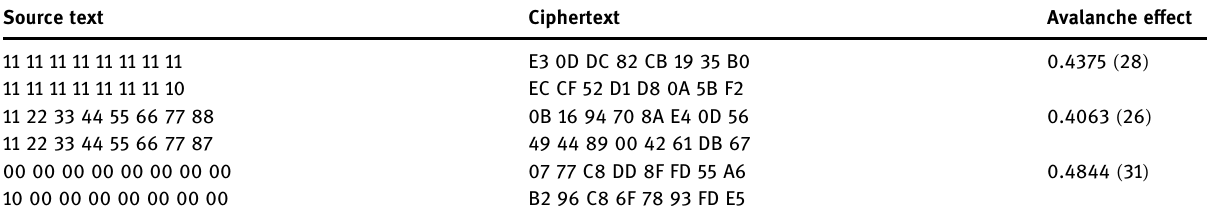
Table 6: Results of the avalanche e ff ect Source text